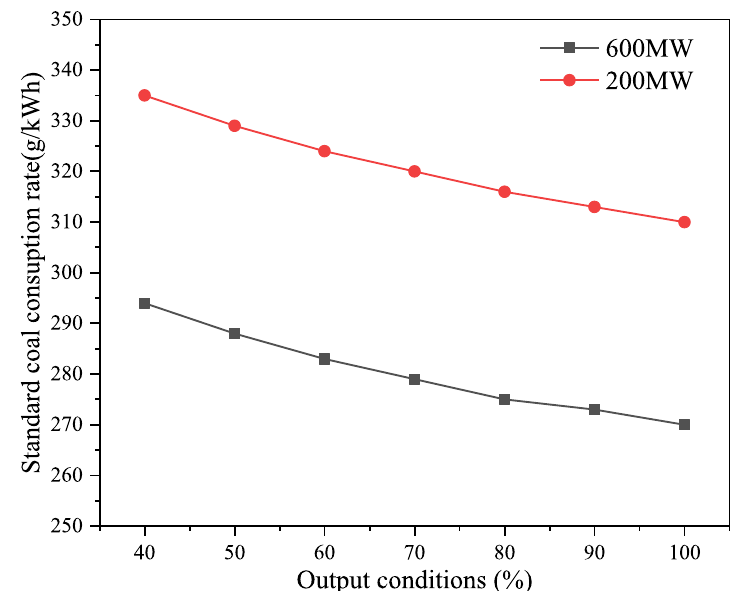
Fig. 1 Coal consumption rate of 200-MW and 600-MW coal fired power plants under different loads